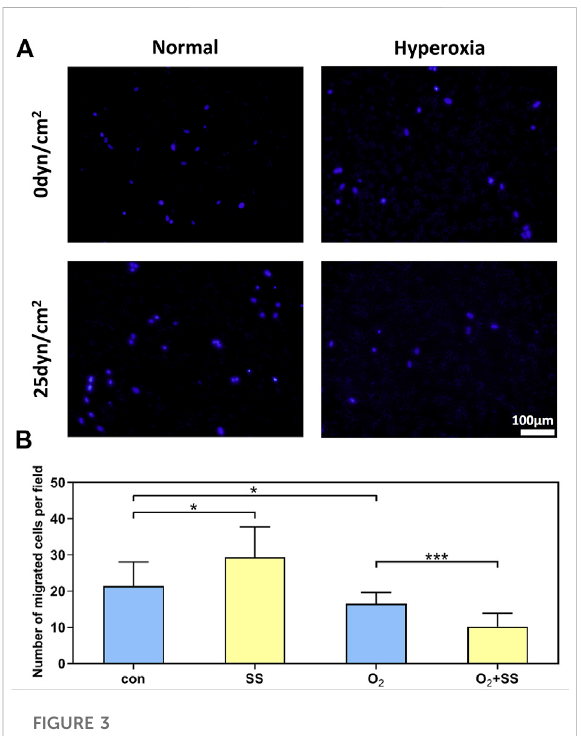
FIGURE 3 Effect of senescence on cell migration of PTM cells in response to shear stress. (A) Transwell migration assay for normal and senescent PTM cells under static conditions or subjected to shear stress (B) Migration activity of normal and senescent PTM cells under static conditions or subjected to shear stress (* p < 0.05, *** p < 0.001). SS stands for shear